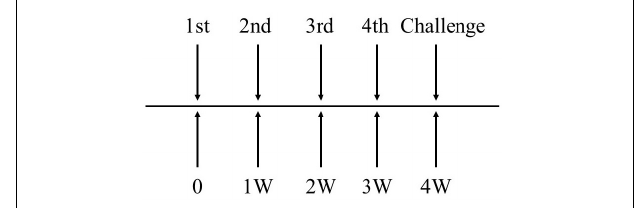
FIGURE 3 | The schematic diagram of immunization plan to mice. Immune dose of EGDeABdd-dat-ompW or EGDeABdd-dat strain was 5 × 10 7 CFUs (about 0.1 × LD 50 ), and immune interval was 1 week. The mice were immunized four times. One week after the fourth immunization, mice were challenged with AH or EGDe of 20 × LD 50 .